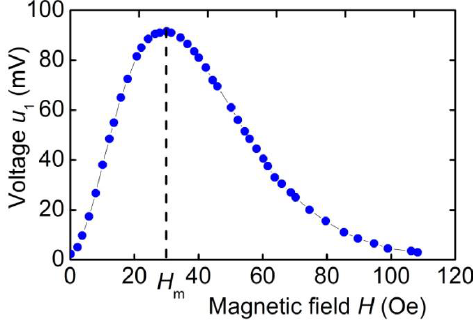
Figure 15. Dependence of ME voltage u on the magnetic field H for the Metglas/PZT/Metglas heterostructure placed in a “magnetic capacitor”.